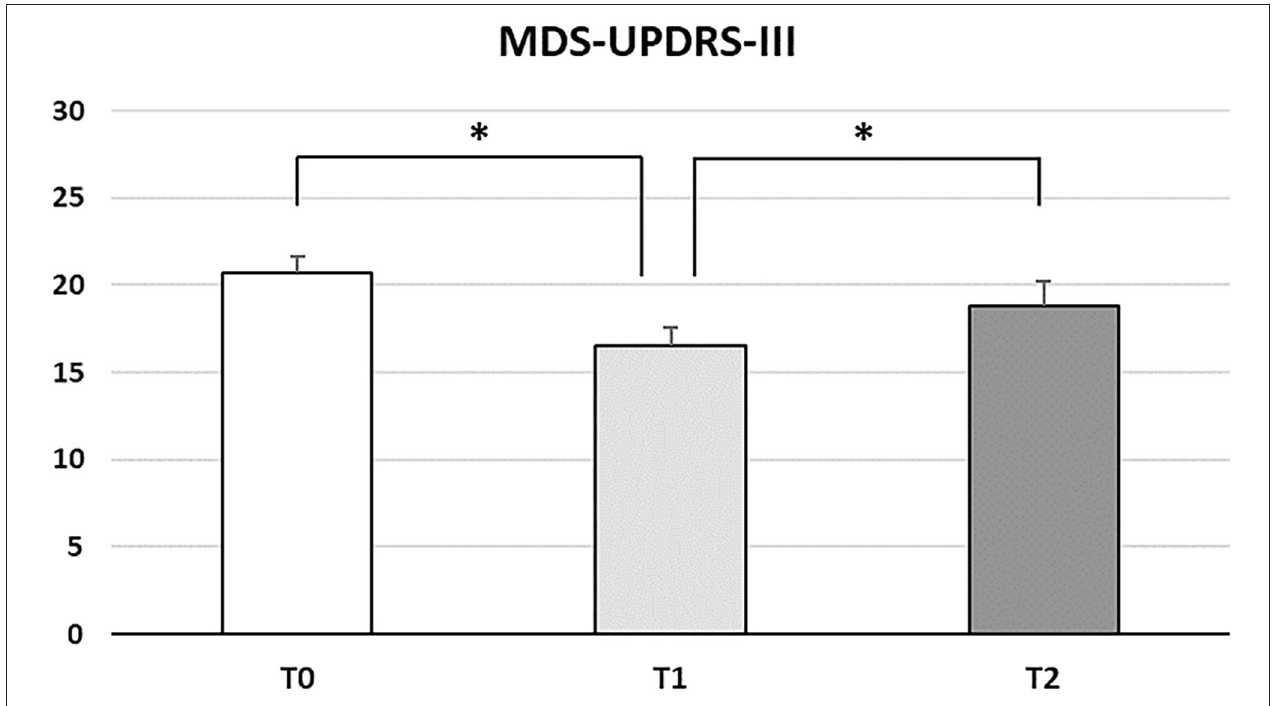
FIGURE 2 | Histogram showing the MDS-UPDRS-III score across time points. Standard error of the mean is shown by vertical bars. Statistically significant differences are marked with an asterisk. The post-hoc analysis showed a reduction between T0 and T1 and a return to baseline at T2.